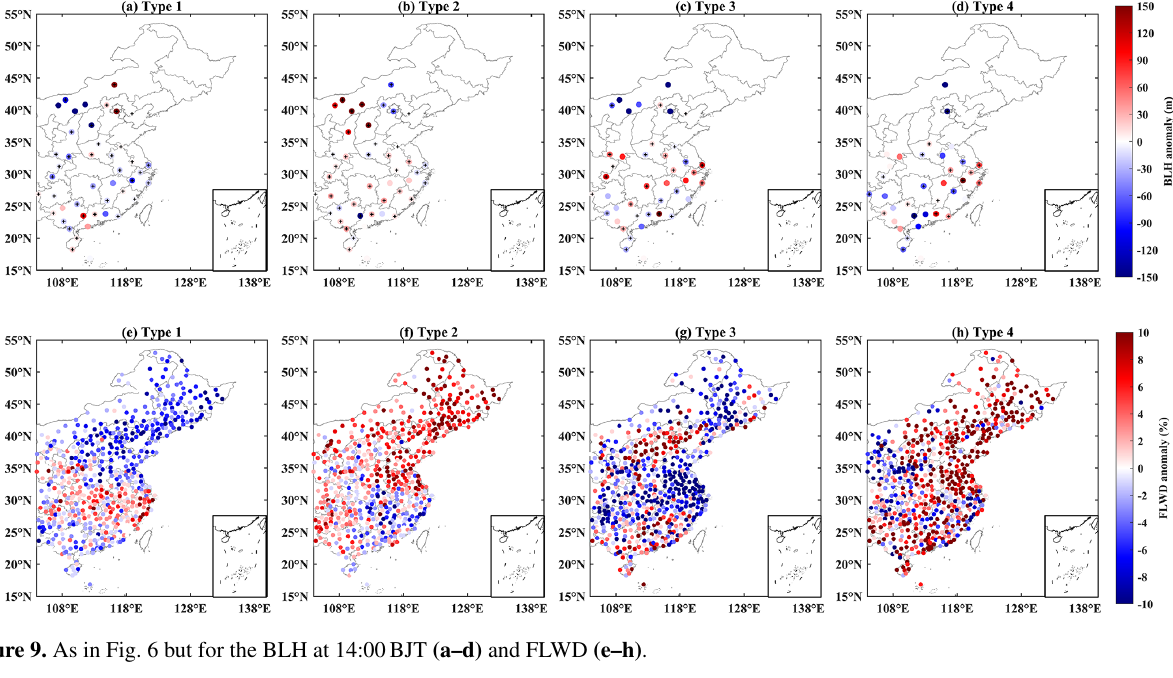
Figure 9. As in Fig. 6 but for the BLH at 14:00BJT (a–d) and FLWD (e–h) .